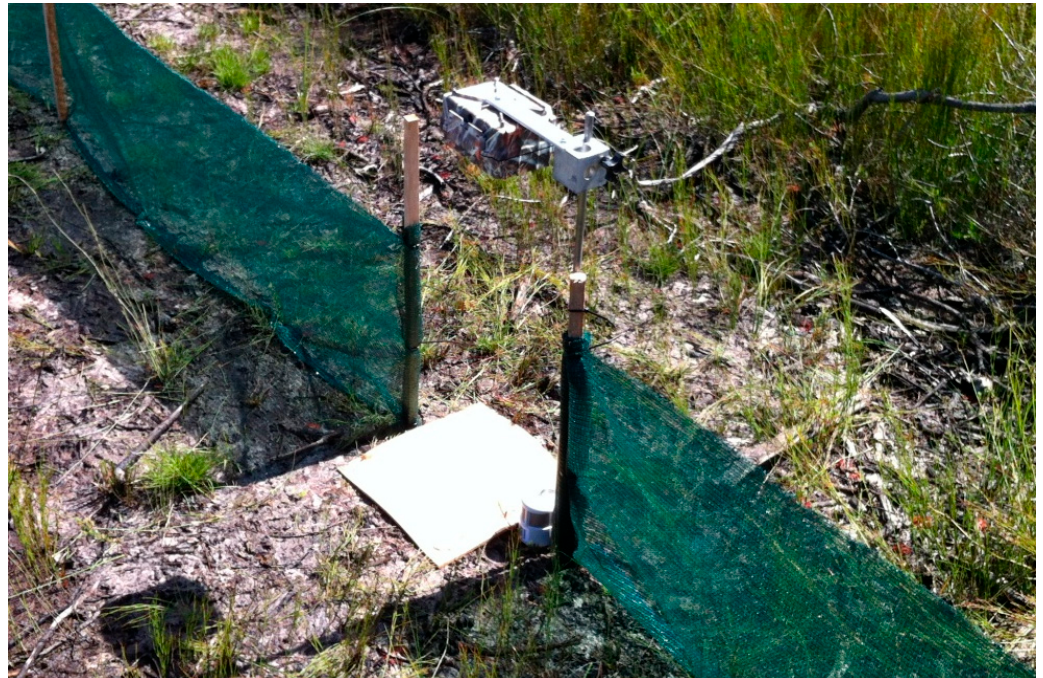
Figure 1: The camera overhead augmented temperature (COAT) camera-trapping method described by Welbourne [4] positions the camera-trap above a focal area that squamates are directed to by drift fences. The cork tile within the detection zone augments the thermal environment and provides the necessary thermal contrast between the target species and the background to generate detections of ectothermic species.